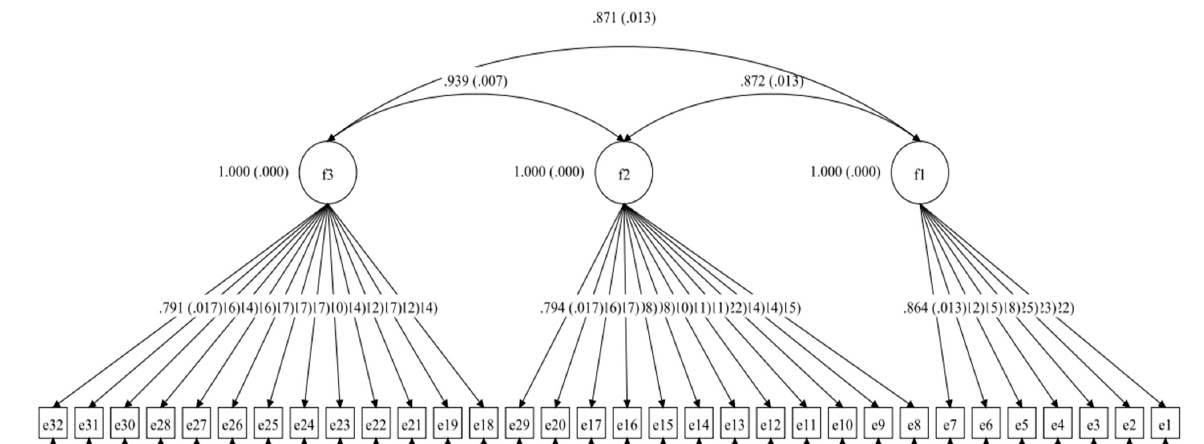
Figure 1. CFA, confirmatory factor analysis; PEESQ, Puhui Early Education Service Quality Scale. Model fit: χ 2 = 984.22, df = 360, χ 2 /df = 2.73, p < 0.000, CFI = 0.97, TLI = 0.96, SRMR = 0.05, RMSEA = 0.02 (90% CI [0.042, 0.043]), AIC = 92,262.40, BIC = 93,040.67.